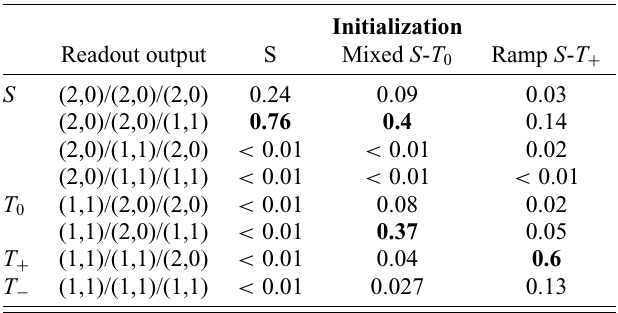
TABLE I. Outcome probability of all the measurements possible for the three initialization tested. For each initializa- tion the measurement procedure is repeated 10 000 times. All the charge-readout outputs are associated with one of the four spin states. The highlighted outputs are the ones to be maximized if the complete readout procedure is